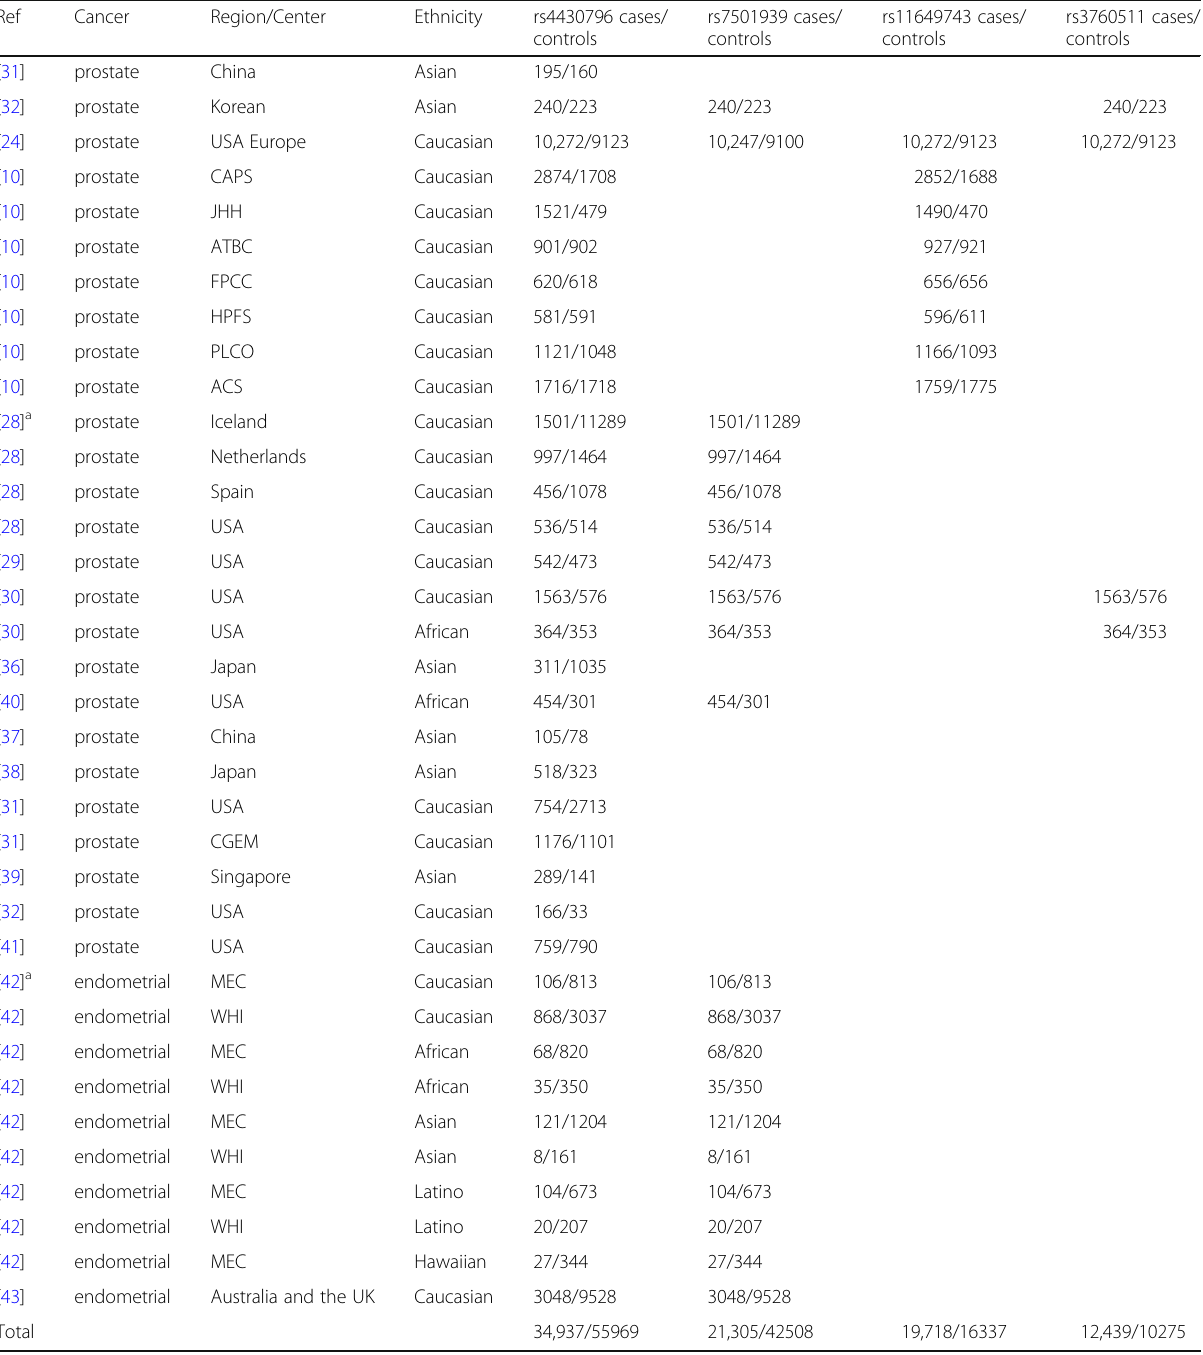
Table 1 Characteristics of case-control studies included in a meta-analysis of the association between HNF1B variants and human